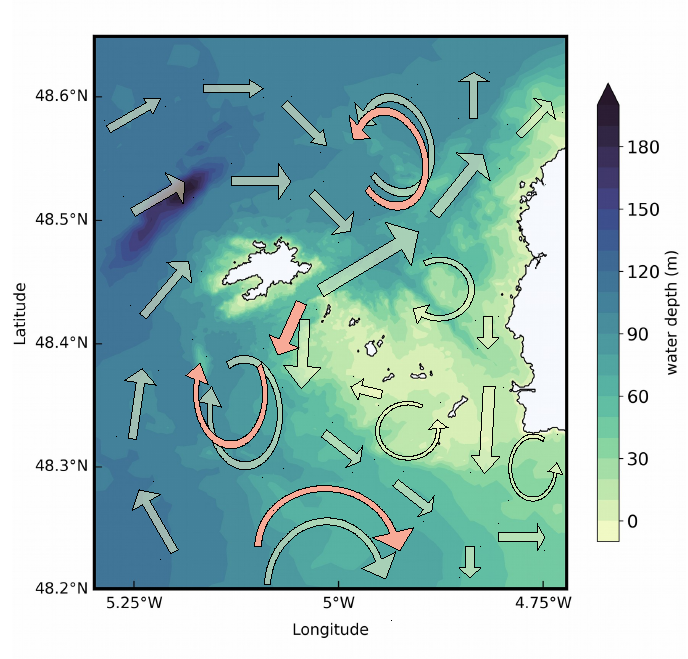
Figure 10. Interpretation of major features of residual Lagrangian currents patterns without tidal stream energy extraction in the Fromveur Strait. The major modifications induced by a full energy extraction scenario are shown with pink arrows (adapted from